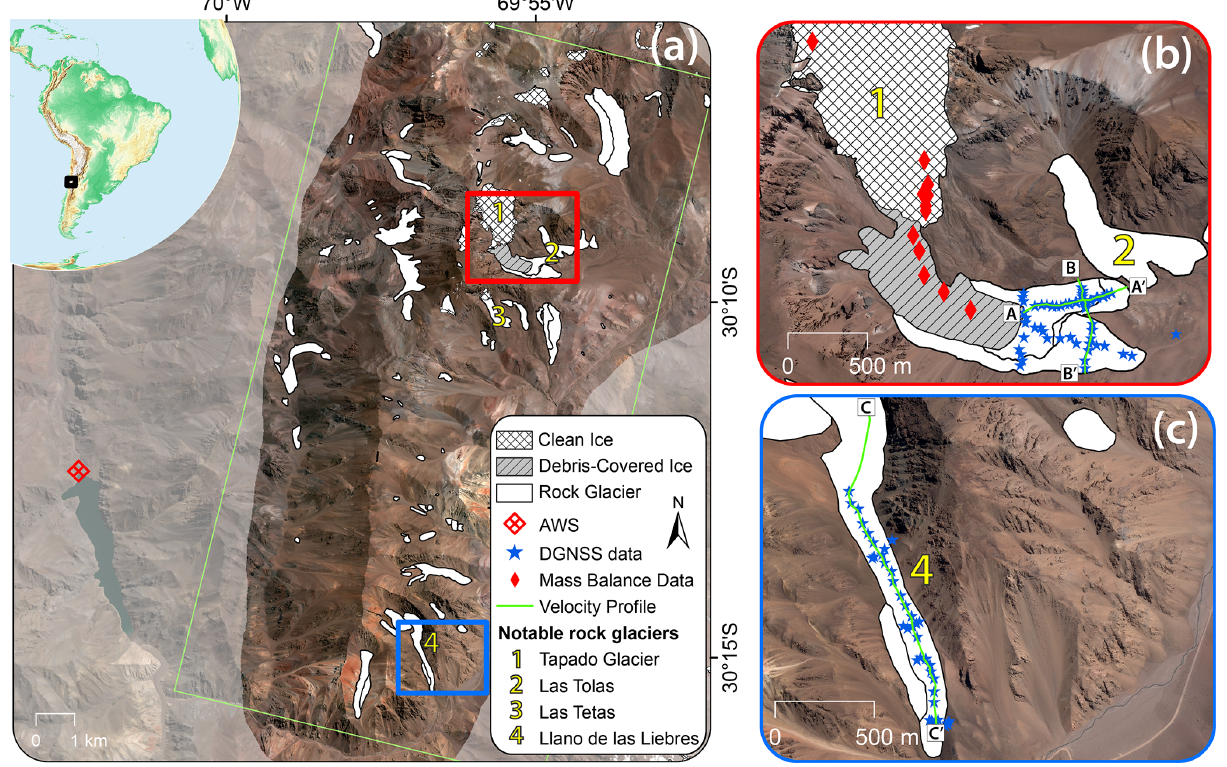
Figure 1. Location of the La Laguna catchment and of landforms studied in this paper. Three landforms that will be discussed in the text are highlighted in panel (a) . The Tapado complex is shown in panel (b) , which contains a clean ice section, debris-covered glacier section, and rock glacier section. In situ field measurement locations are shown in panels (b) and (c) . The automatic weather station (AWS) is shown in panel (a) . Background imagery: (a) Pléiades imagery (2020) overlaying Sentinel 2 imagery (2018); (b) Pléiades (2020) imagery; (c) cross- blended hypsometric tints obtained from https://www.naturalearthdata.com/ (last access: 10 September 2020). © CNES (2018) and Airbus DS (2018), all rights